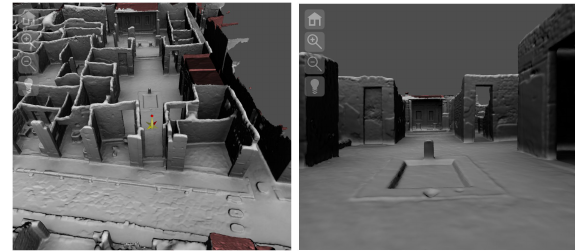
Figure 3: Switching from bird’s eye to first-person preserves the user position and orientation, as it is visible in these